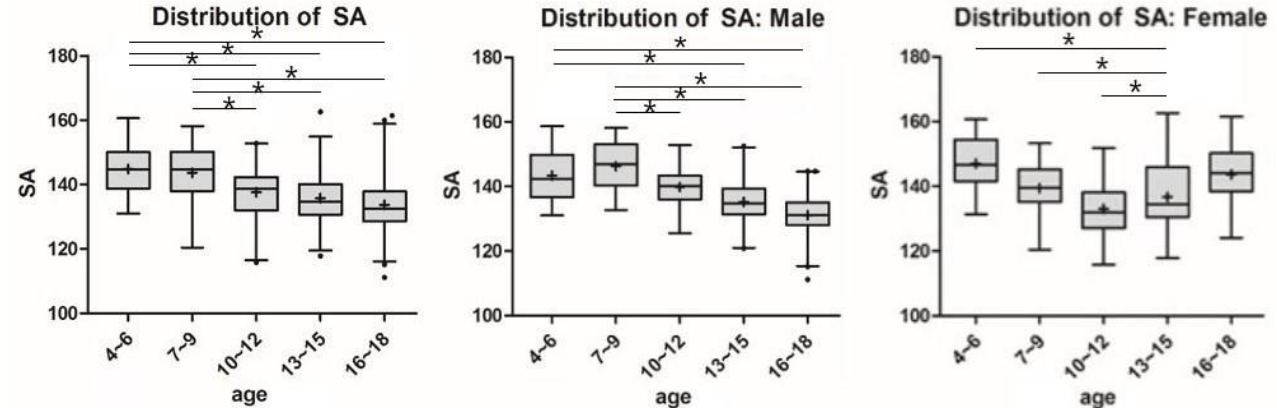
Figure 4. Parametric distribution of sulcus angle in MRI Measurements. The line and the asterisk indicate a significant difference between the two groups using post-hoc analysis. * means the p < 0.05.